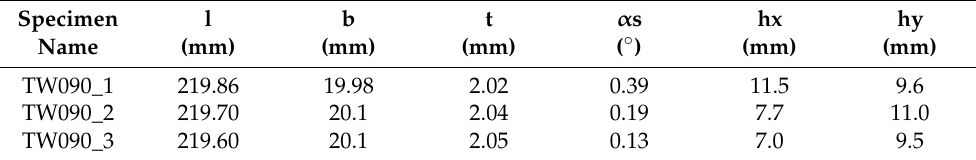
Table 2. Measured dimensions of manufactured test specimens.